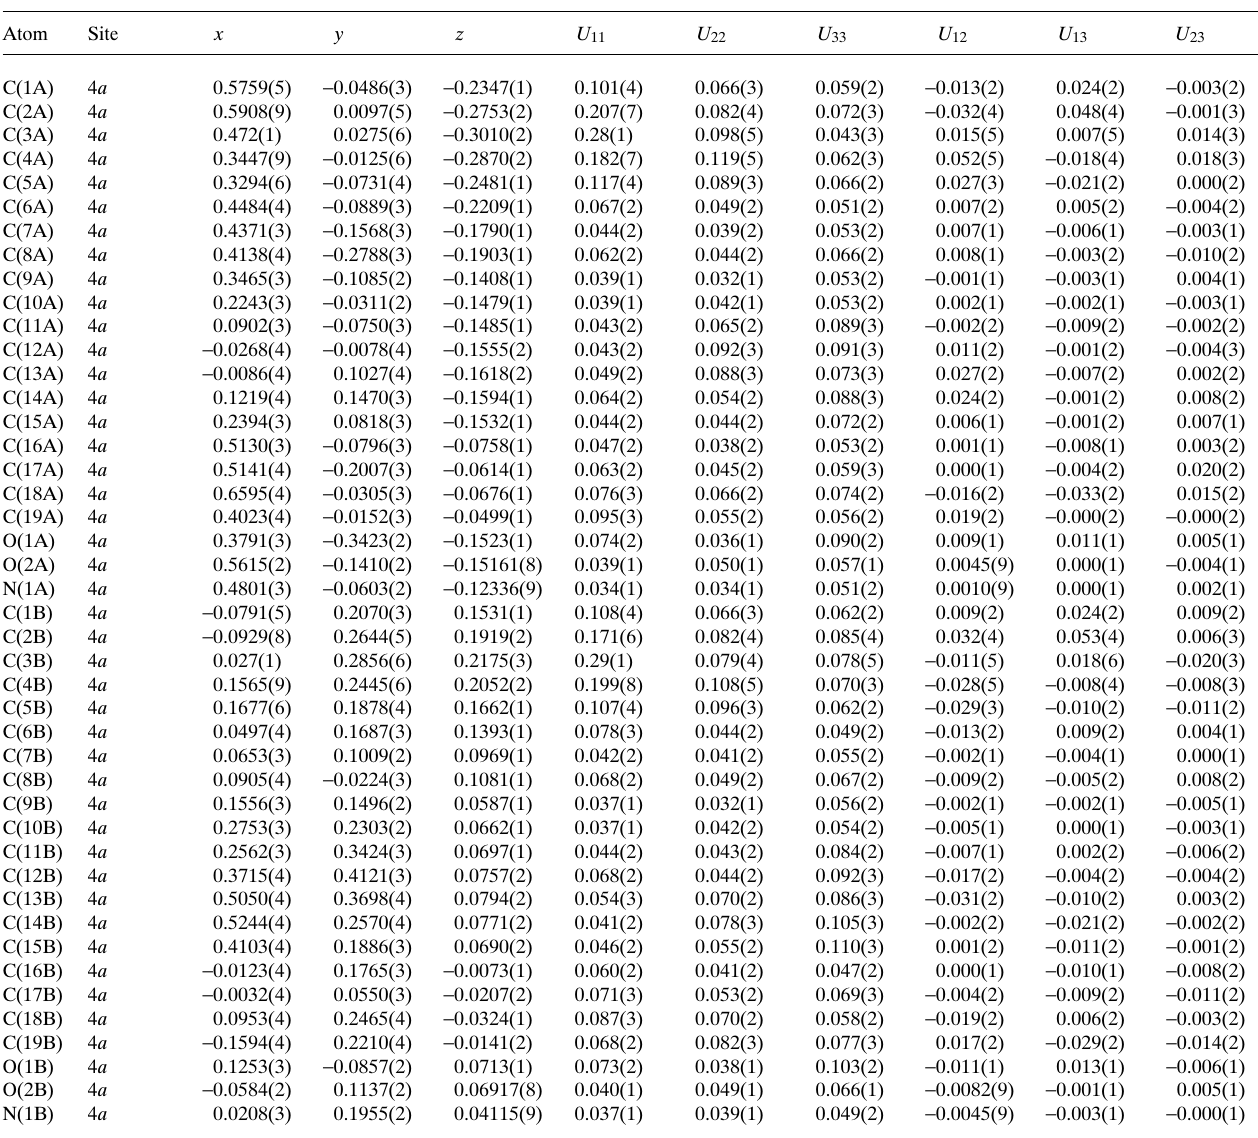
Table 3. Atomic coordinates and displacement parameters (in Å 2 )